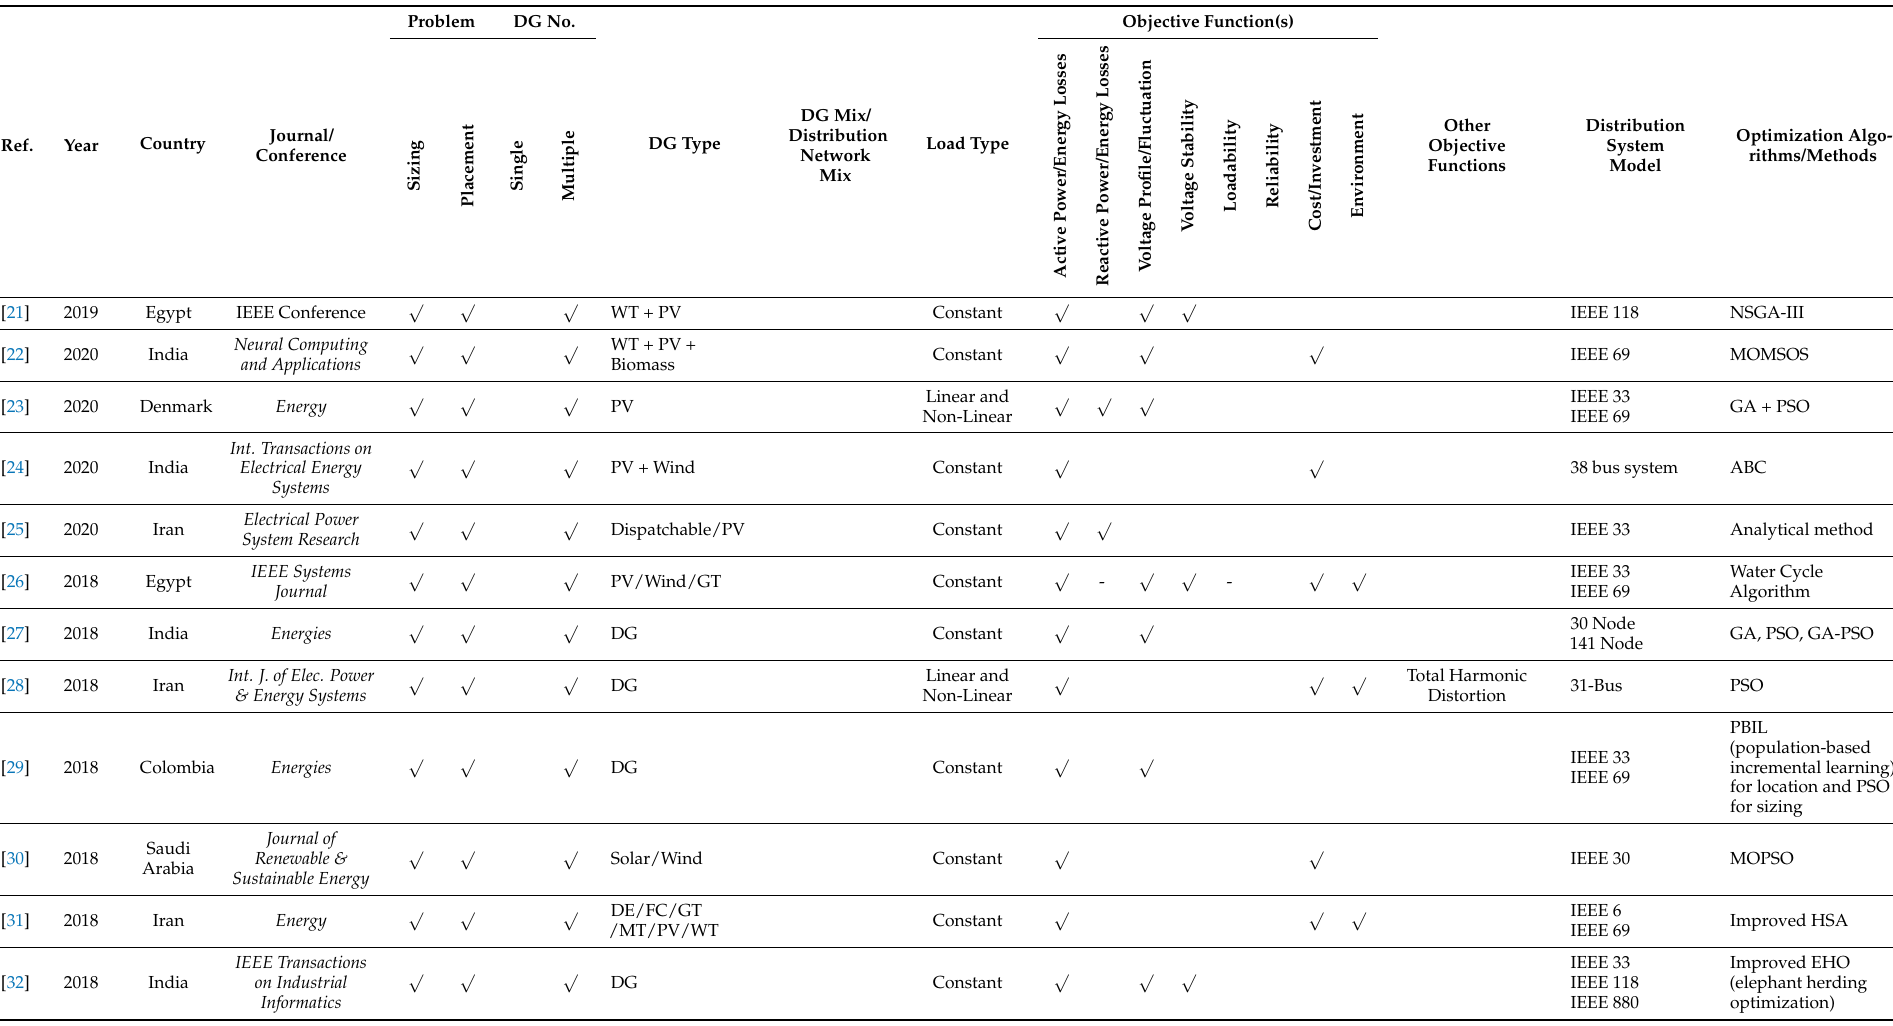
Table 1. Summary of literature reviewed for the optimal multi-objective placement and sizing of DG in the distribution system.